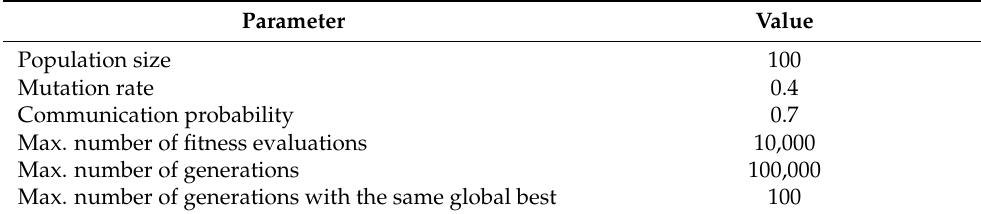
Table 3. Strategic parameters of